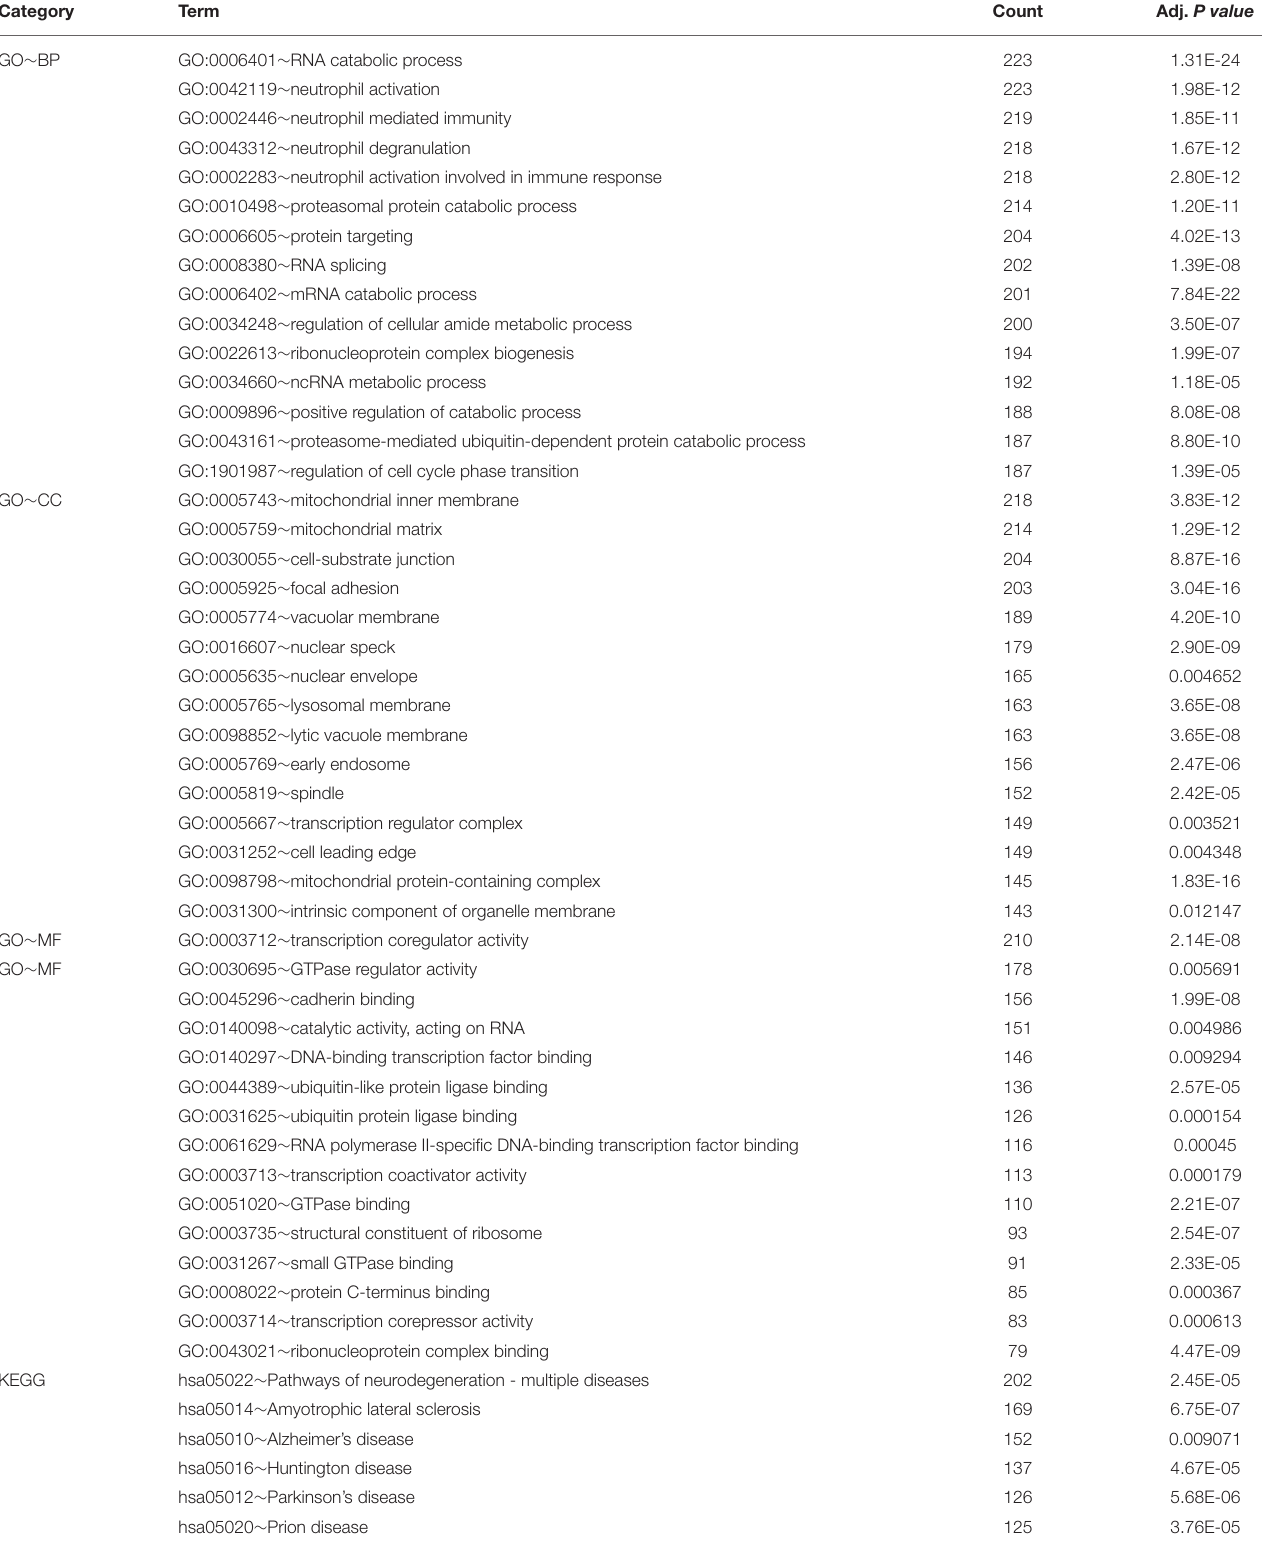
TABLE 3 | GO and KEGG enrichment terms of co-expressed genes of DEMRGs. Category Adj. P